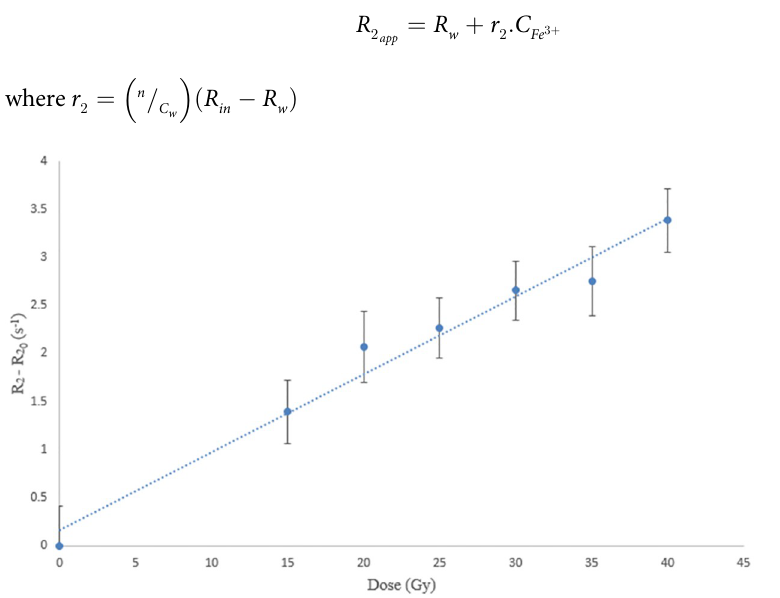
Fig 5. Gel dose response measured with vegetable oil at low energy for 6 irradiation dose levels (15, 20, 25, 30, 35 and 40 Gy). The equation of the linear regression (dotted line) is R